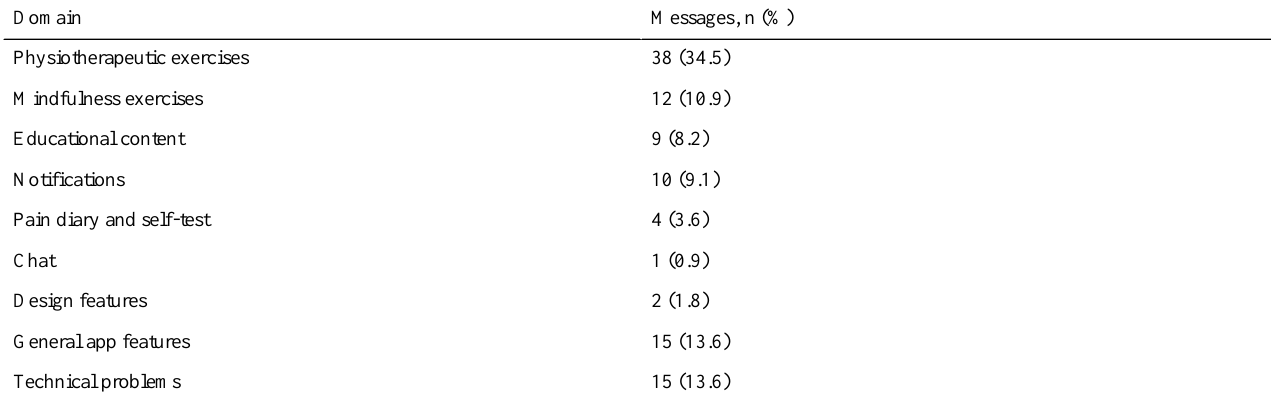
Table 1. Domains of app affected by